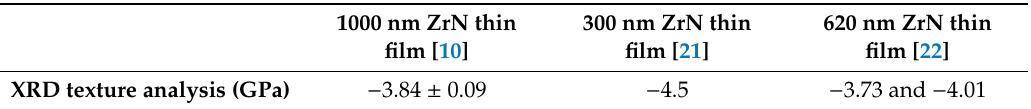
Table 5. The residual stress measurement results of ZrN thin films compared with the values obtained from the XRD of other literatures.